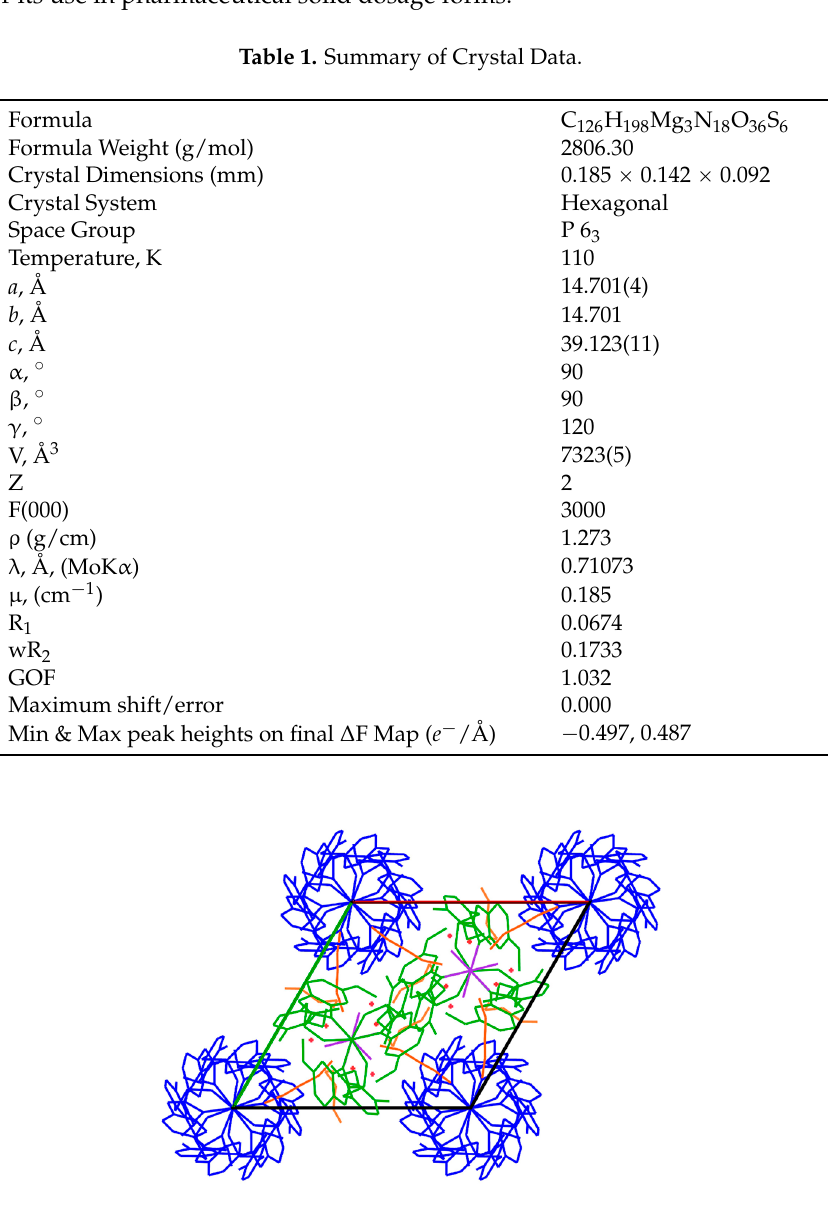
Table 1. Summary of Crystal Data.